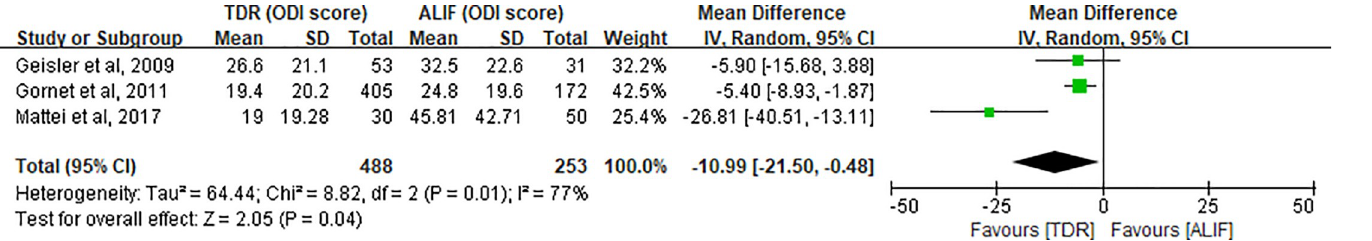
Fig 6. Forest plot for ODI score at the final follow-up. df = degrees of freedom, and IV = Inverse Variance.